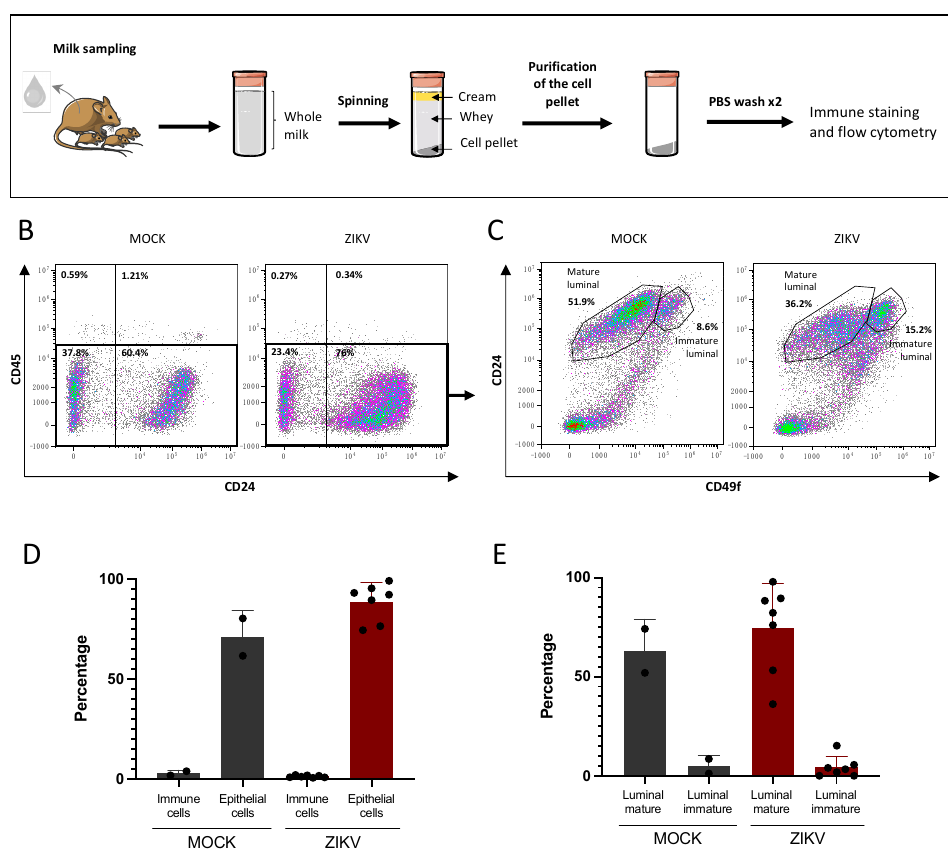
Figure 3. Breast milk cells of infected or non-infected mice are in majority mammary epithelial cells. ( A ): Breast milk samples collected from MOCK or ZIKV-infected dams with the Brazil/2016 strain at 4 days post-infection were centrifuged to separate the cream fraction, the whey, and the cell pellet. The cells were then subjected to two spin-wash cycles in PBS in order to eliminate any free viral particles left from the liquid fractions. Antigen expression was analyzed by immune staining and flow cytometry. ( B ): Anti-CD45 and anti-CD24 antibodies were used to detect and quantify immune and epithelial cells respectively. ( C ): CD49f expression was used to identify mammary epithelial cells among the CD45-negative cells determined in ( B ). The results of one experiment are presented (MOCK: n = 2, ZIKV: n = 7). ( D ): histogram representation of CD45-positive (immune) or CD24-positive (epithelial) cells in breast milk of MOCK or ZIKV-infected dams (MOCK: n = 2, ZIKV: n = 7). ( E ): histogram representation of mature and immature luminal mammary cells in breast milk, determined among the CD45-negative cells (MOCK: n = 2, ZIKV: n = 7).